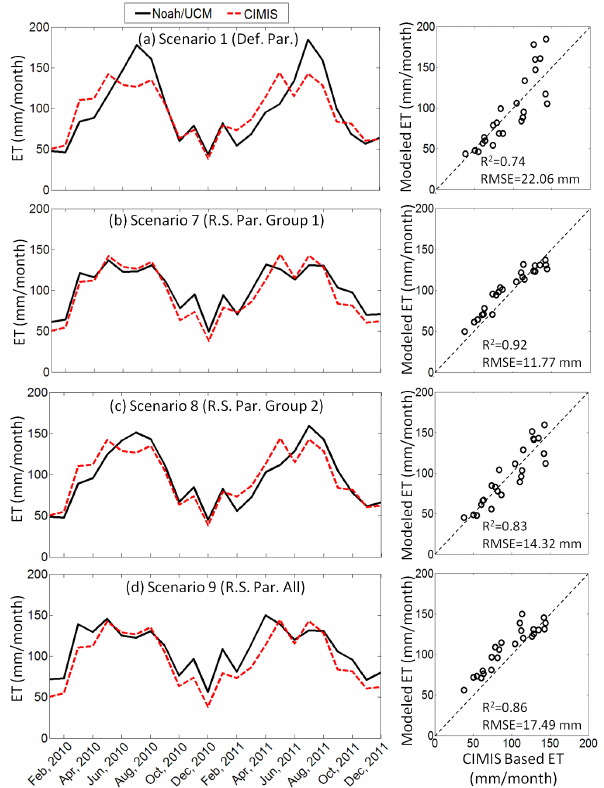
Figure 4. Noah-UCM-simulated cumulative monthly ET, averaged over fully vegetated pixels using different urban surface parameter- izations: scenarios (a) 1, (b) 7, (c) 8, and (d) 9 in the Table 1 and their comparisons with CIMIS-based ET measurements spanning 2010 and 2011. Scatter plots of these comparisons are also included